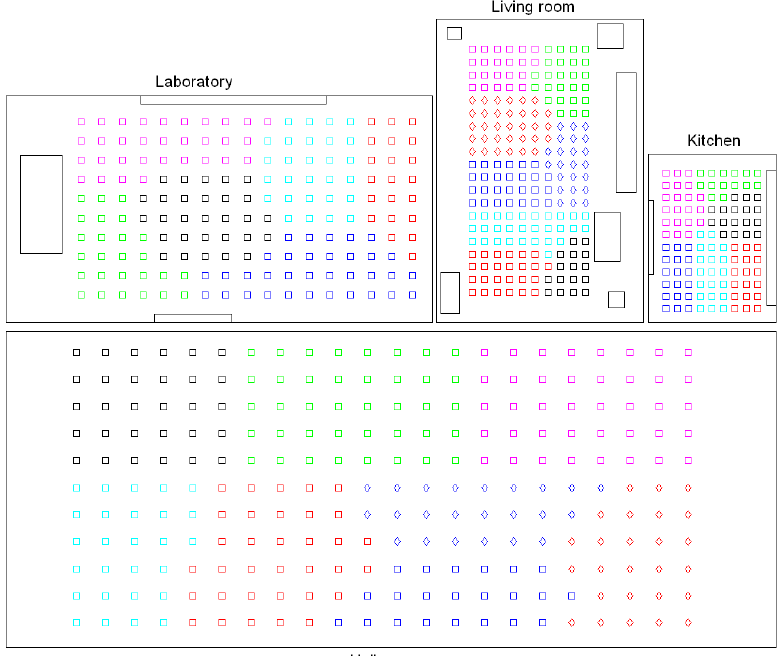
Figure 17. Results of the intermediate-level mapping using Fourier signature with k 1 = 32 components per row. Bird’s eye view of the four rooms of the Bielefeld set. The colors of the capture points indicate the cluster they belong